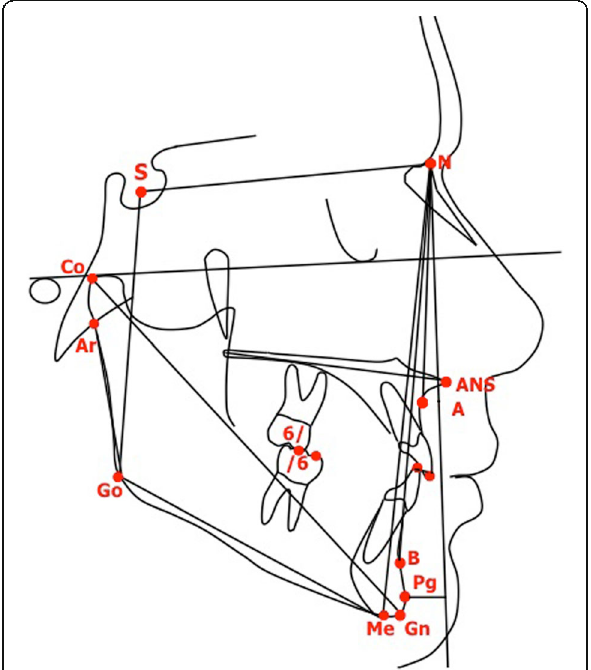
Fig. 2 Cephalometric points, lines, and angles used in analysis: SNA angle (maxillary sagittal position), SNB angle (mandibular sagittal position), ANB angle (maxillomandibular sagittal discrepancy), point Pg to Nasion perpendicular (sagittal mandibular position relative to Frankfurt plane), mandibular total length (Co-Gn), SN to mandibular plane (Me-Go), gonial angle (Ar-Go-Me), lower anterior facial height (ANS-Me), overjet, overbite; molar